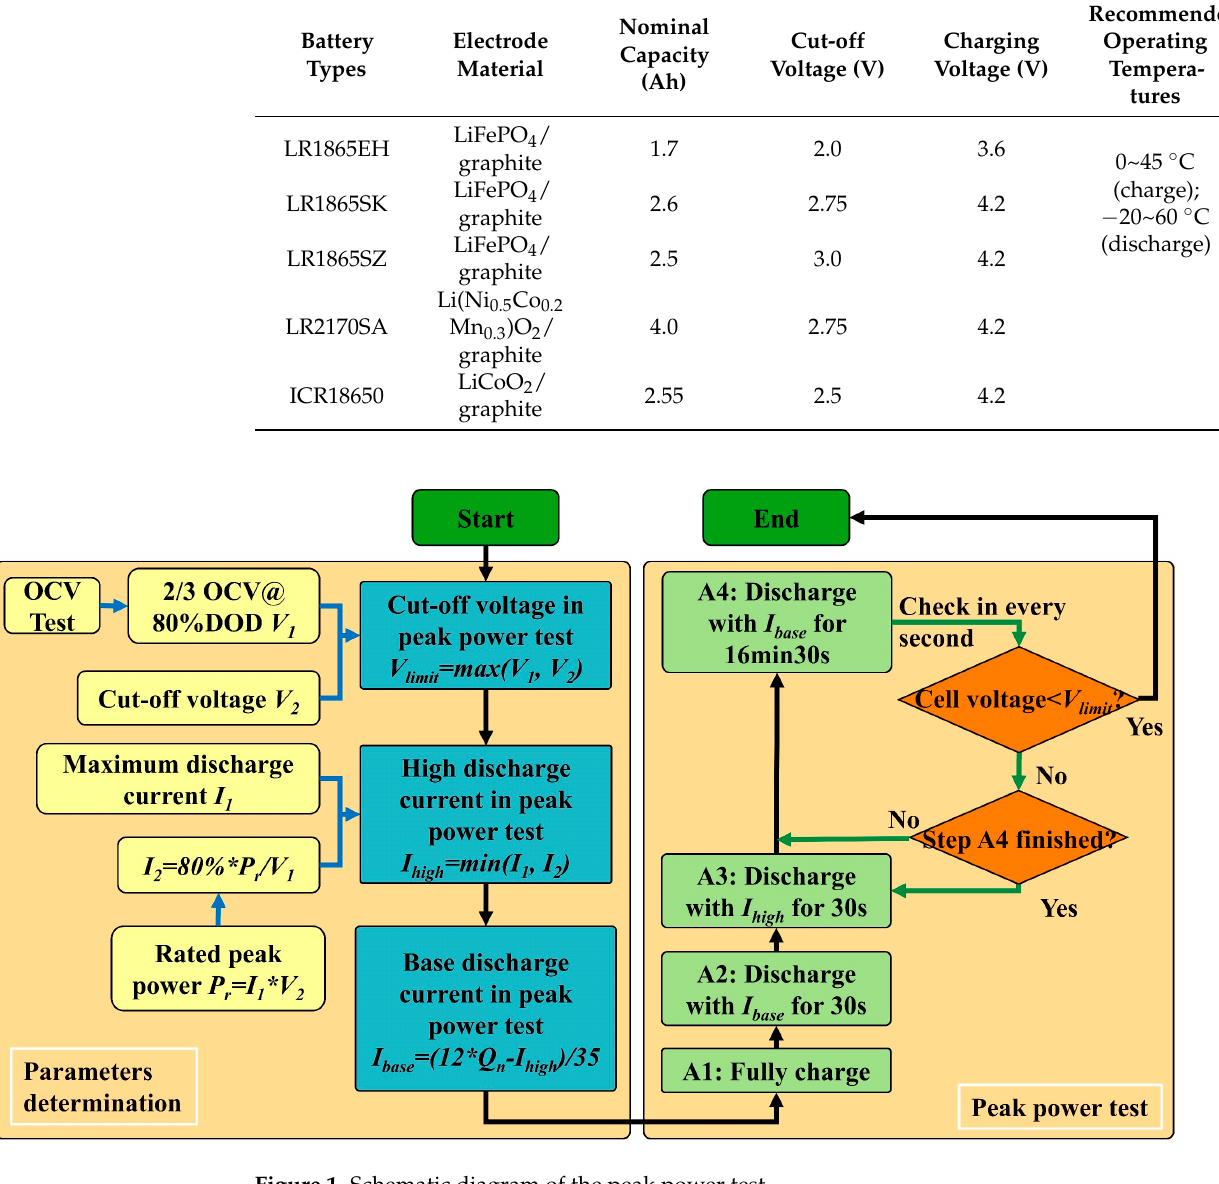
Table 1. Details of five types of battery information.